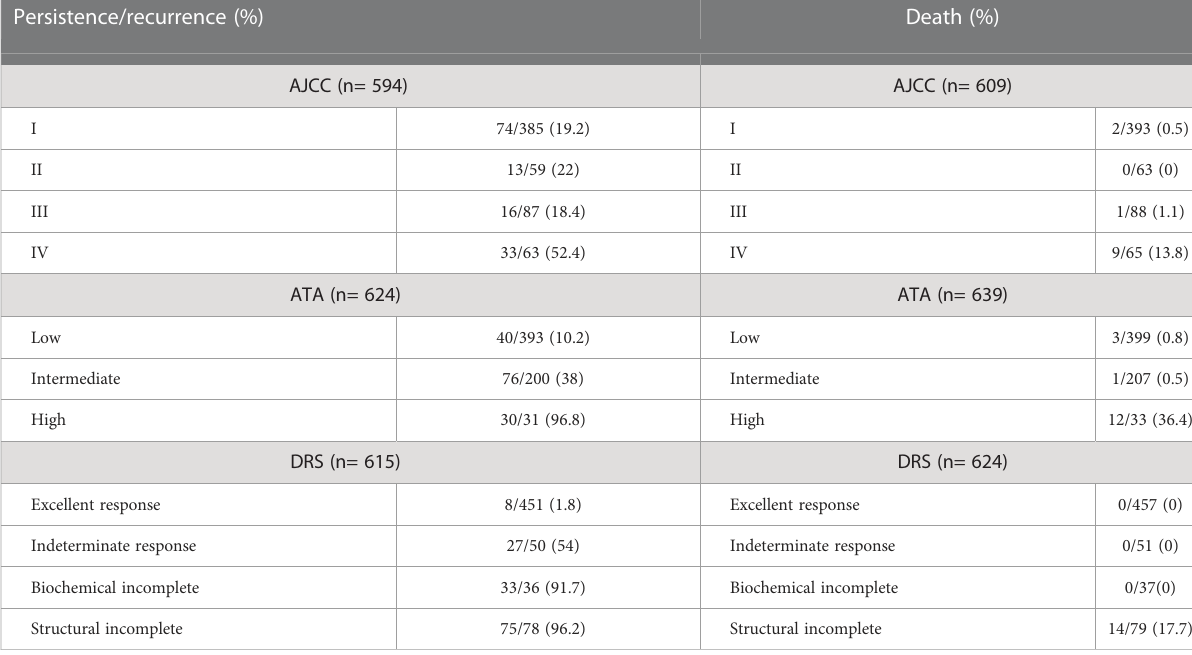
TABLE 3 Final outcomes based on strati fi cation by AJCC, ATA risk of recurrence at diagnosis and DRS. Persistence/recurrence (%)